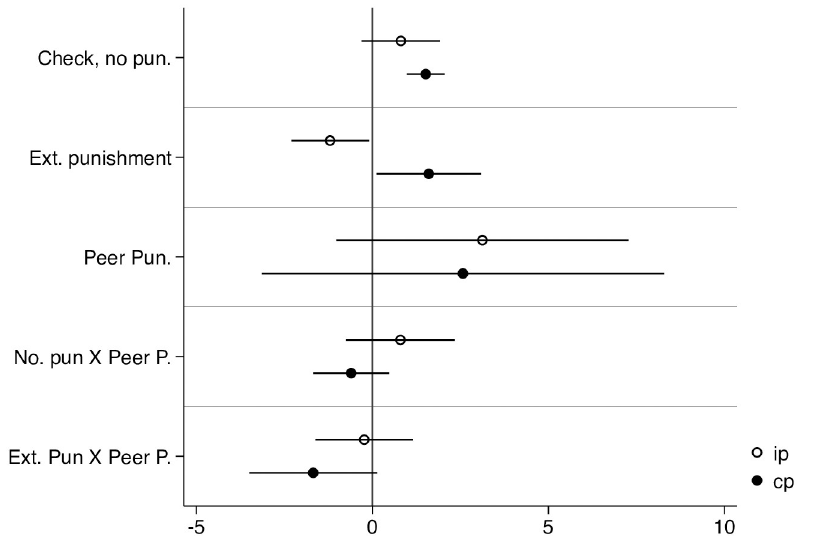
Fig 6. Panel OLS (random-effect). DV: Contribution. All IVs are lagged ( t − 1).